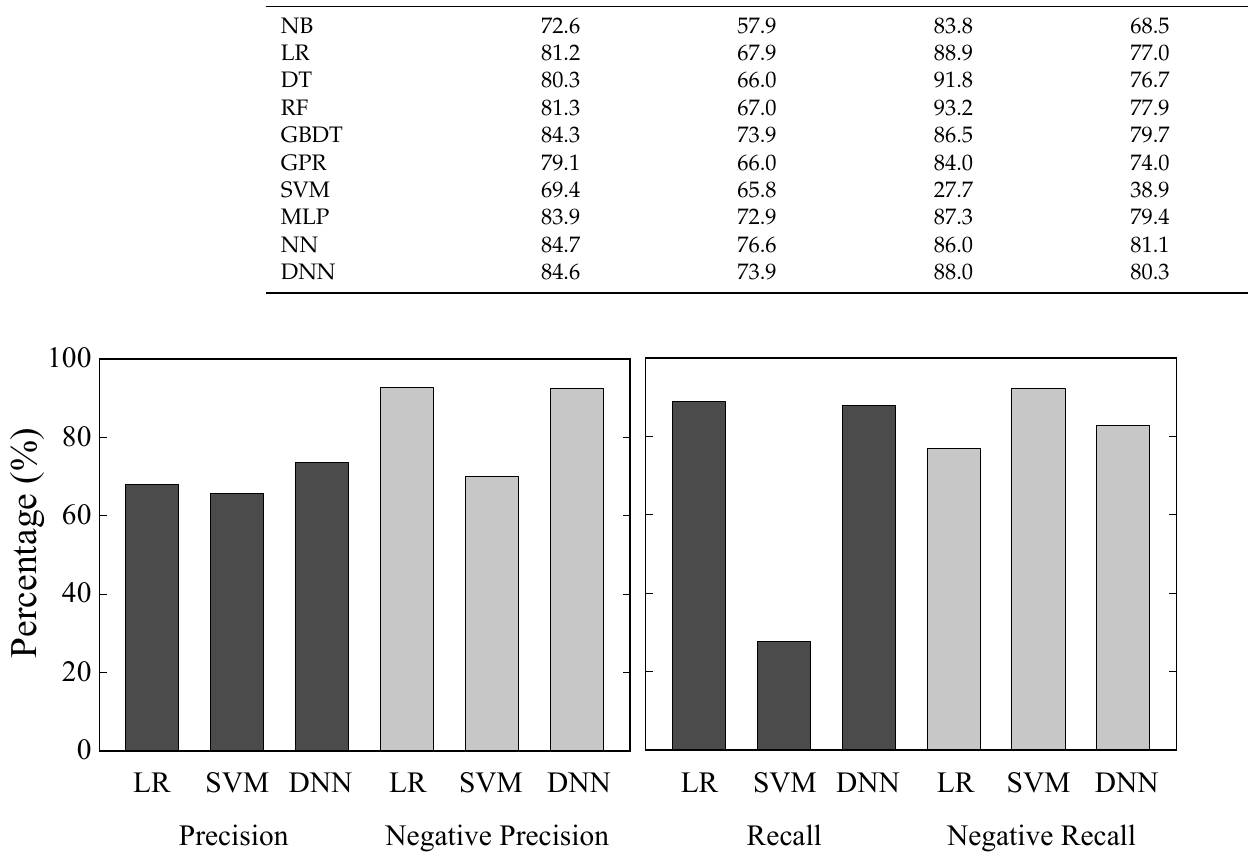
Figure 5. Comparison of Precision, Negative Precision, Recall, and Negative Recall in Section 3.2.